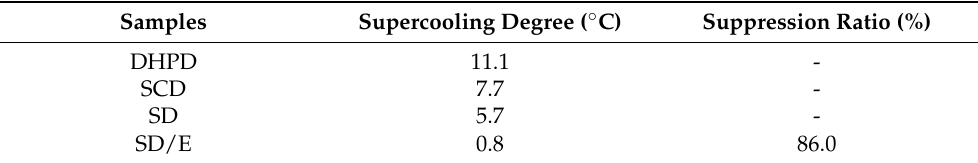
Figure 5. Time-temperature curves: ( a ) SCD and DHPD; ( b ) SD and SD/E. Table 2. The supercooling degrees of hydrated salts and form-stable composite phase change materials